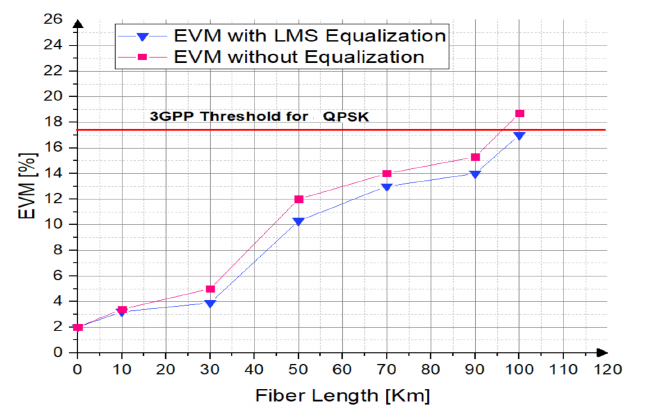
Figure 11. EVM results obtained before and after equalization vs. the fiber lengths for a QPSK constellation.